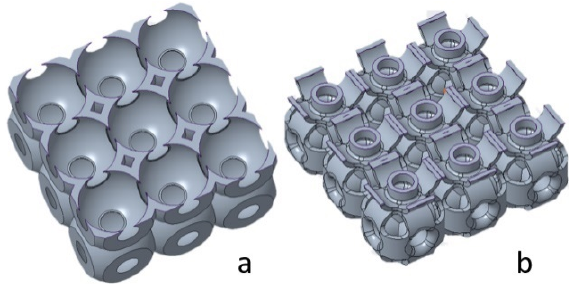
Figure 1. Basic design mechanism of ( a ) SU structure ( b ) O-Surface structure.